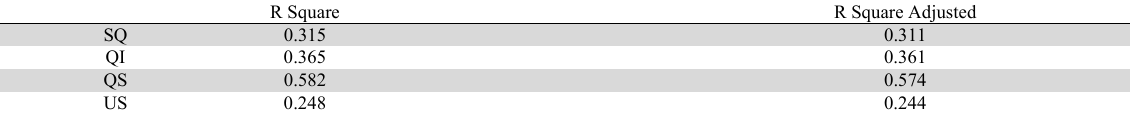
The results of R-Square